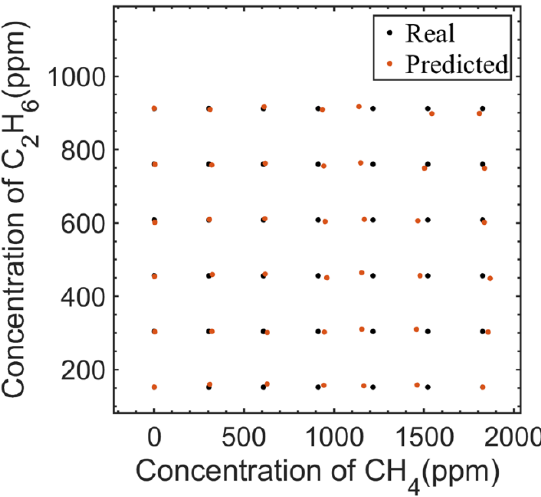
Figure 13. Predicted concentrations of CH 4 and C 2 H 6 using simulated mixed gases spectra.